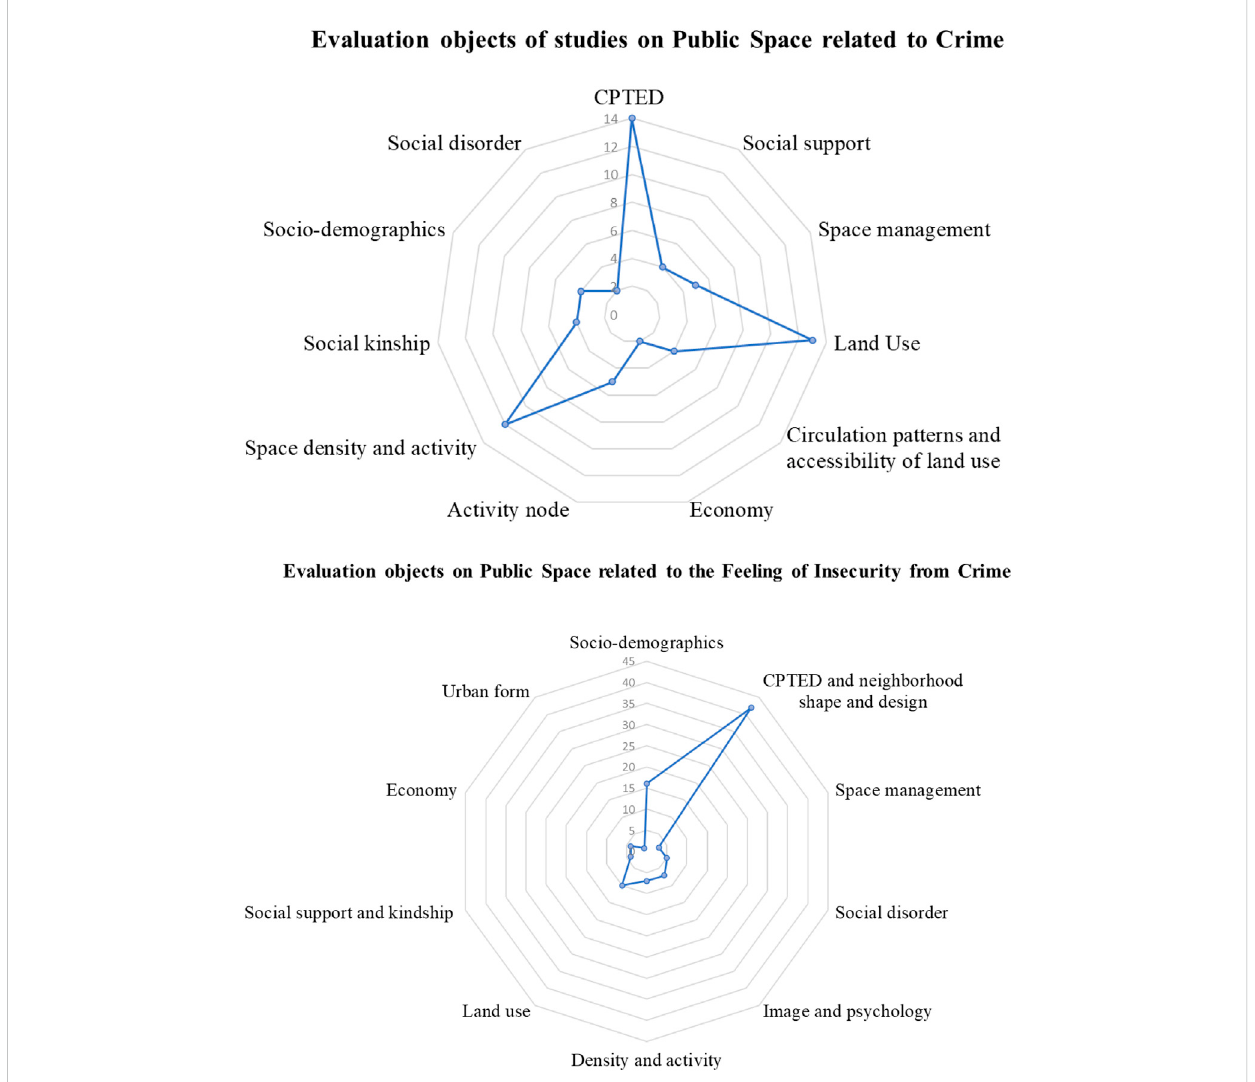
FIGURE 2 Various substance scales in studies on the feeling of insecurity from crime in public spaces during 1970 –